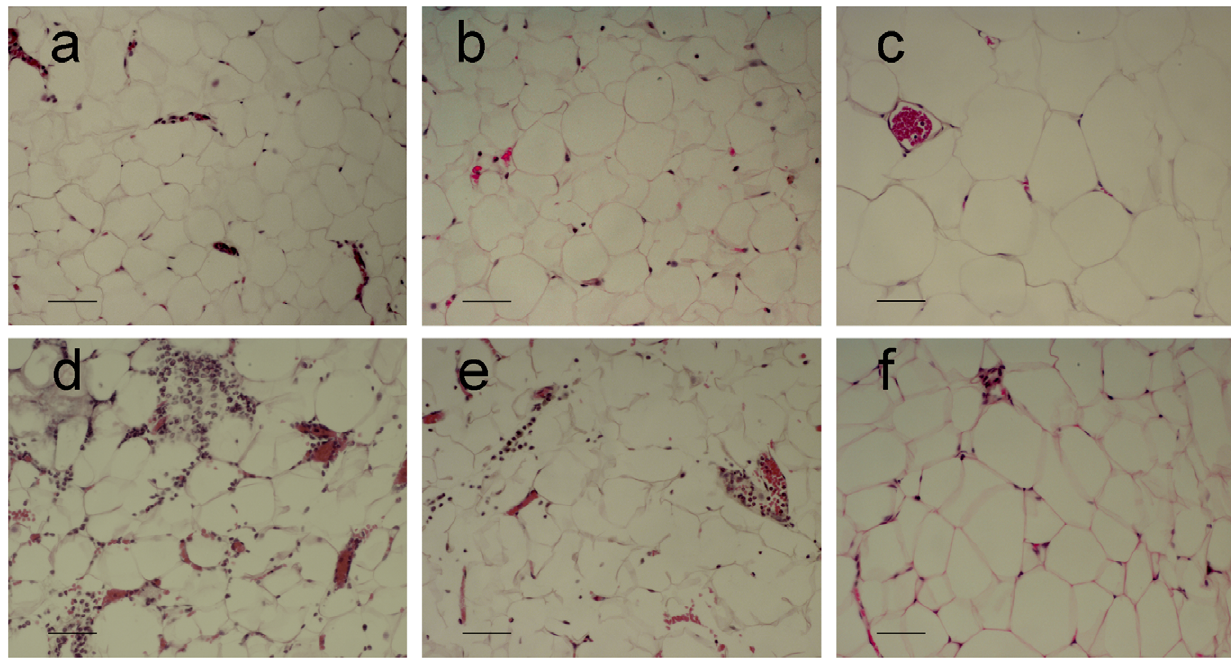
Figure 5. Adipocytes from retroperitoneal areas (c) are higher than that from mesenteric (a) and epididymal (b) regions of adipose tissue. In addition, the number of stromal cells was higher in these regions of adipose tissue. After induction of pancreatitis, an important cell infiltrate could be observed in mesenteric (d) and epididymal (e) areas. By contrast, no relevant infiltrate was observed in retroperitoneal adipose tissue